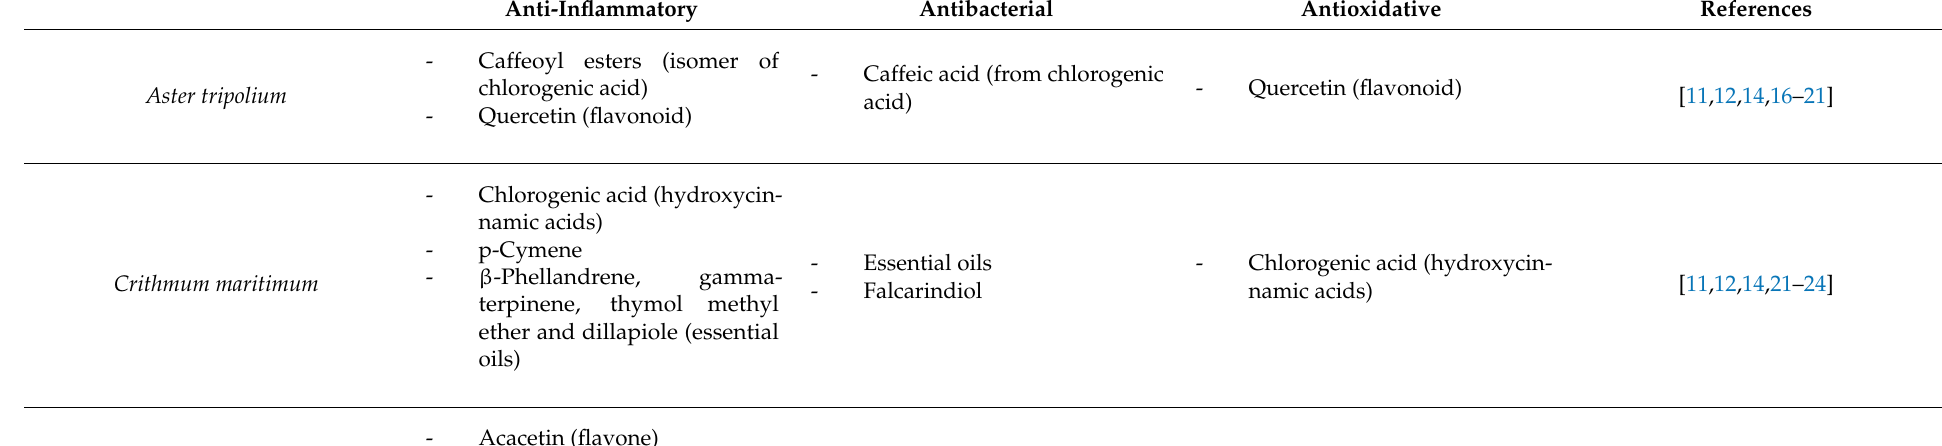
Table 1. Anti-inflammatory and antibacterial activities of several halophytes based on their bioactive compounds.